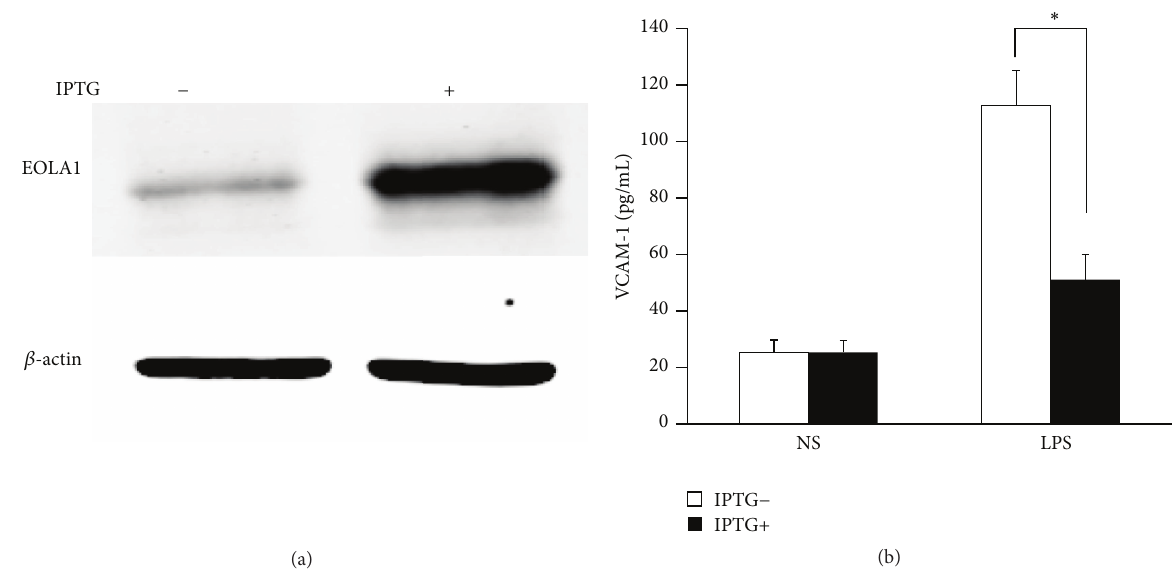
Figure 3: Overexpression of EOLA1 prevents LPS-induced VCAM-1 production in ECV304 cells. ECV304 cells were transfected with pOPRSVI-EOLA1-EGFP and pCMV-LacI plasmids and induced by IPTG. (a) Overexpression of EOLA1 was demonstrated by Western blotting analysis with anti-EOLA1 antibody after adding IPTG for 48h. (b) The induced cells with IPTG were tested for their ability to produce VCAM-1 upon LPS stimulation (100ng/mL) for 6h using a commercial ELISA kit. Data represent the mean ± SD of three independent experiments ( ∗ 𝑝 < 0.05